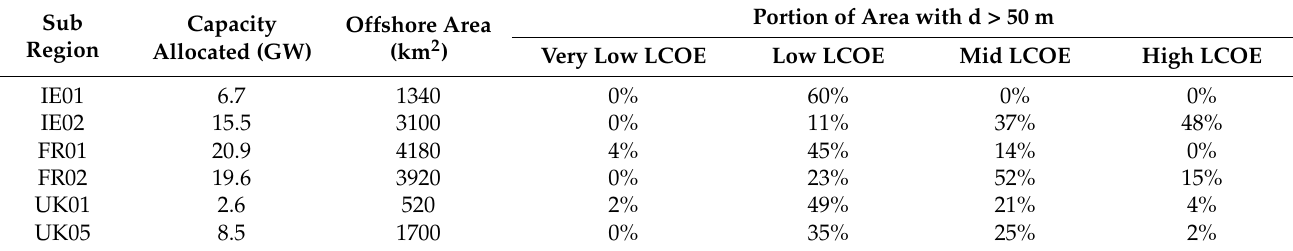
Table 2. Floating share in each sector